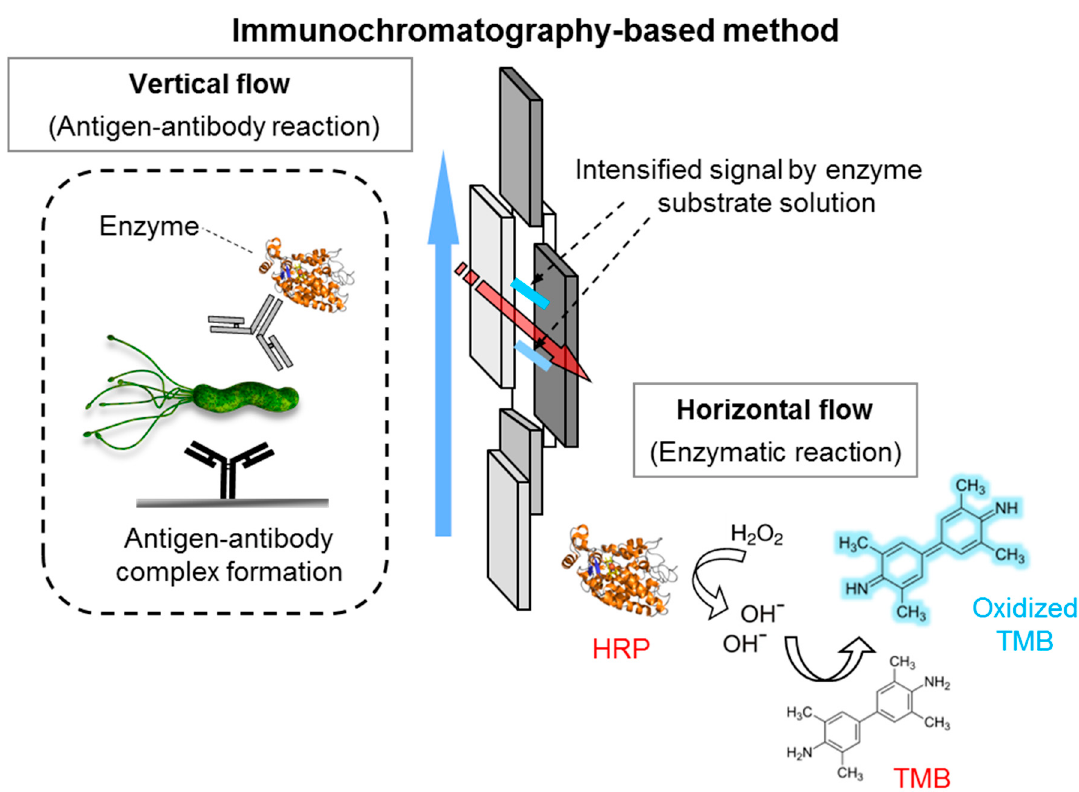
Figure 9. Schematic illustration of colorimetric analytical method associated with enzyme-based immunochromatography (e.g., horseradish peroxidase) for onsite testing. Consists of sequential vertical and horizontal flows of the antigen-antibody reaction and enzymatic color signal generation, respectively. The signals (e.g., oxidized tetramethylbenzidin) adsorbed on the membrane pad can be analyzed qualitatively and quantitatively.